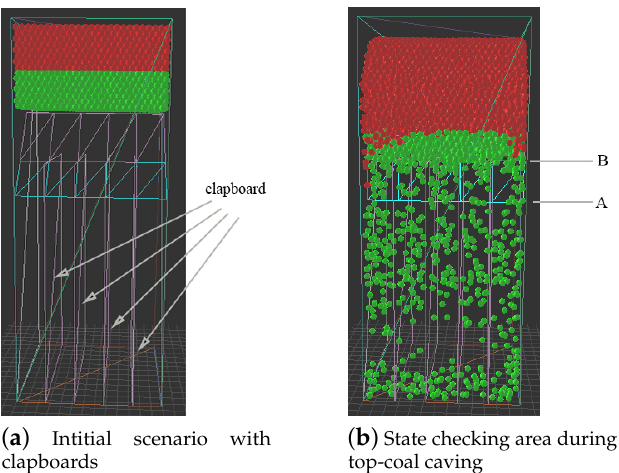
Figure 3. Setting for training DQN: ( a ) The clapboards are added between each hydraulic support for distinguishing the particles belongs to which windows, while they are removed in the testing. ( b ) The state check area is the stereo area between A and B of each hydraulic support; this area is the range of the window